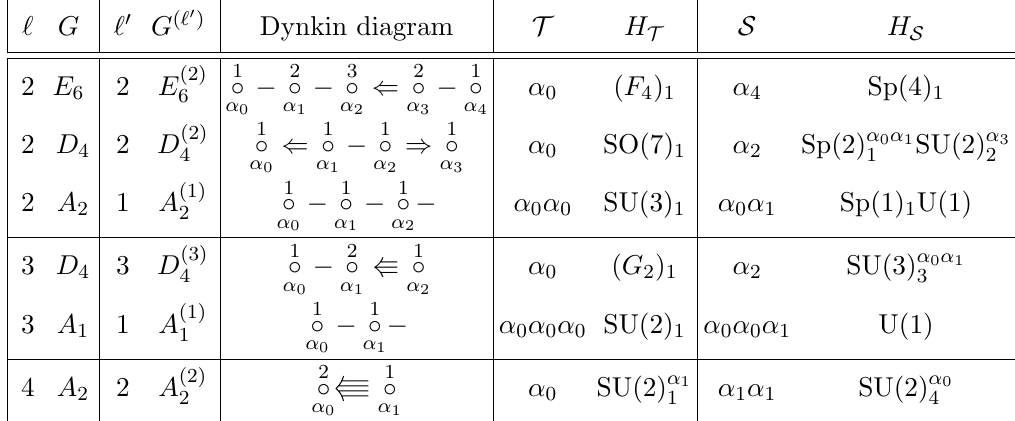
Table 6. The possible choices of asymptotic holonomies on the S-folds. Here, the extended Dynkin diagrams of type A (1)